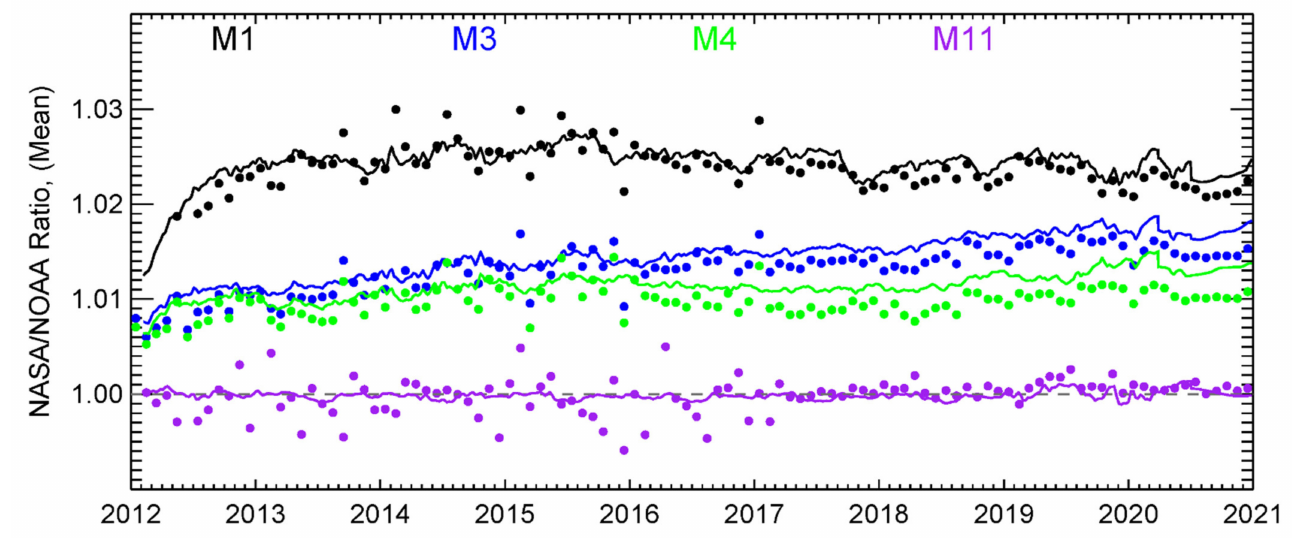
Figure 4. NASA-NPP-C2/NOAA-NPP-V2 ratio time series for bands M1, M3–M4, and M11: filled cycles (DCC ratio) and solid lines (F-factor